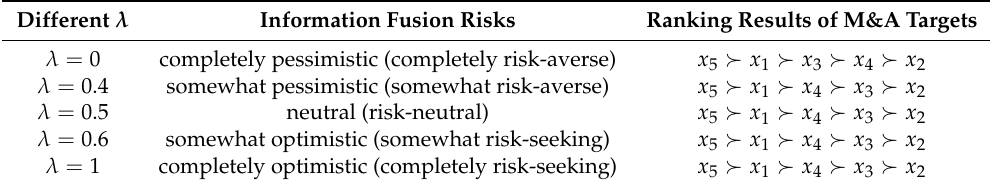
Table 1. Ranking orders of M&A targets with changing values of λ . Information Fusion Risks Ranking Results of M&A